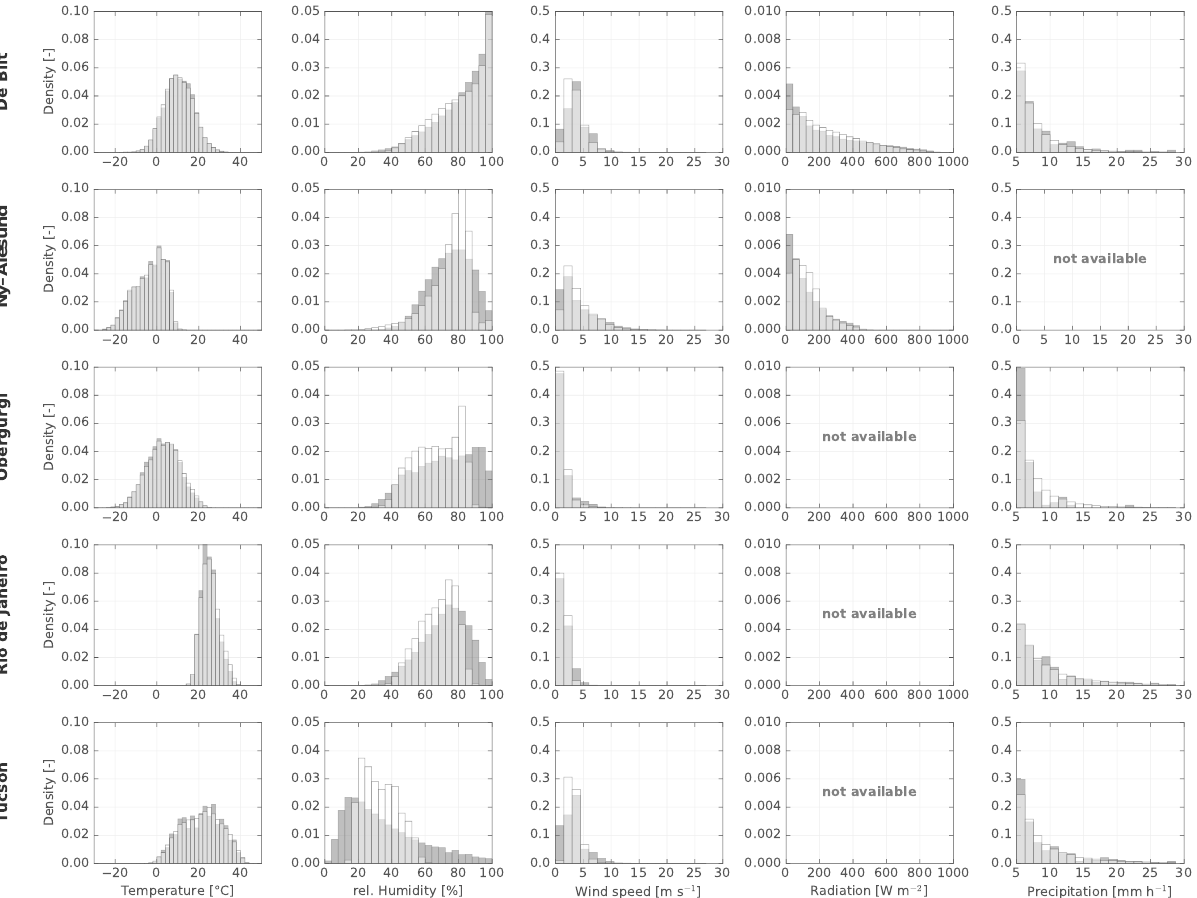
Figure 8. Histograms of observed and disaggregated time series for each variable (columns) and each station (rows). Observed (disaggre- gated) time series are displayed in grey